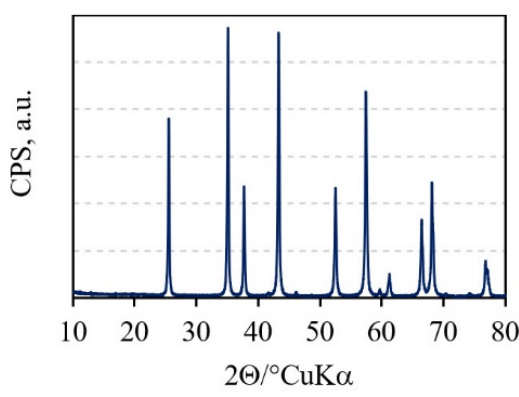
Figure 2. XRD pattern of alumina granules. The hybrid microwave sintering process led to the formation of fine grains and small pores in the bulk alumina material (Figure 3). The obtained grains do not show a specific orientation or a uniform grain size. The calculated average grain size of 2.1 µ m, determined by the line intercept method [41,42], is in accordance with findings in the literature [43–46]. The average grain size of the same alumina ceramics sintered in a high-temperature electric kiln (conventional sintering) at the same temperature was greater, i.e., 7.6 µ m [24]. The grain size decreases in hybrid microwave sintering compared to conventional sintering due to the shorter sintering time. The measured bulk density was 3.784 ± 0.028 g cm − 3 (Table 4), while the relative porosity was 5.1 ±